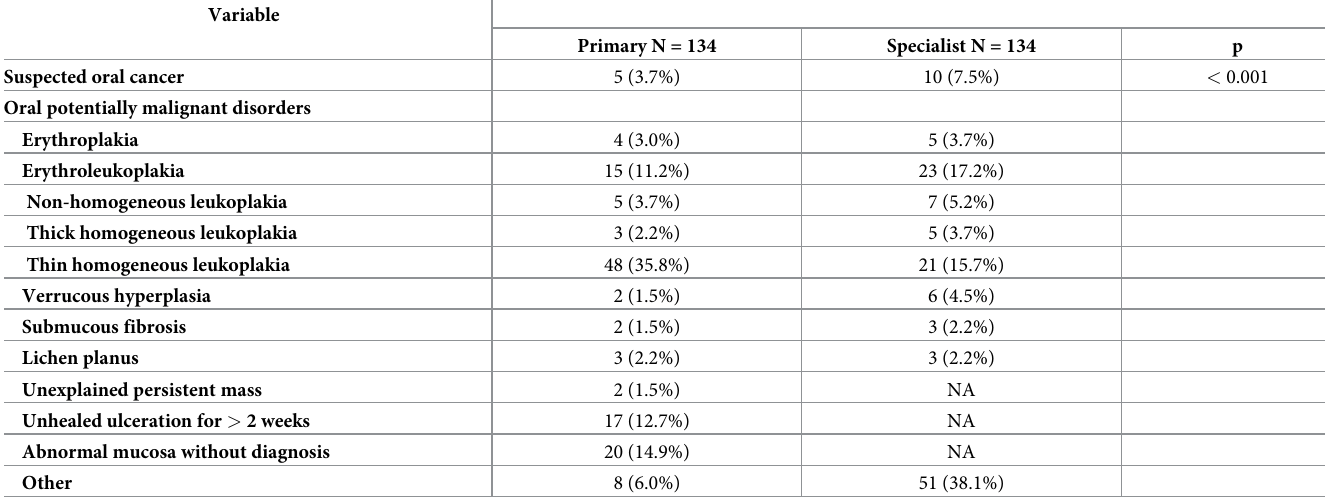
Table 2. Clinical diagnoses made by the primary examiner and the specialist using the Taiwanese Nationwide Oral Mucosal Screening